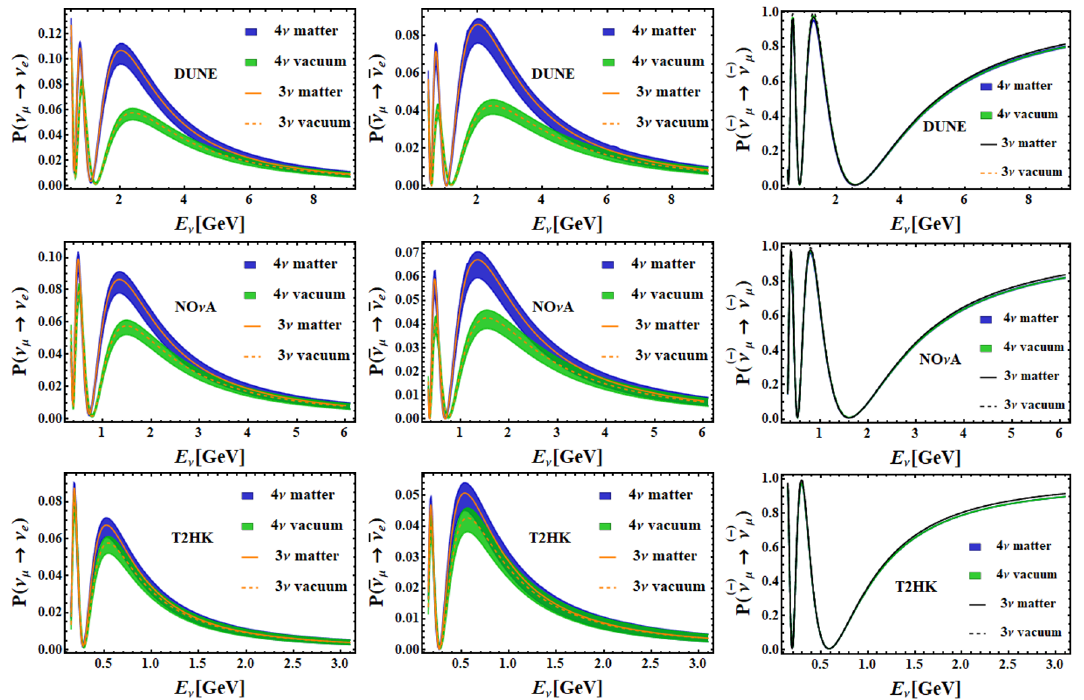
Figure 4 . Prospects of muon neutrino and antineutrino oscillation probabilities in DUNE, NO (cid:23) A and T2HK experiments, listed from the top to